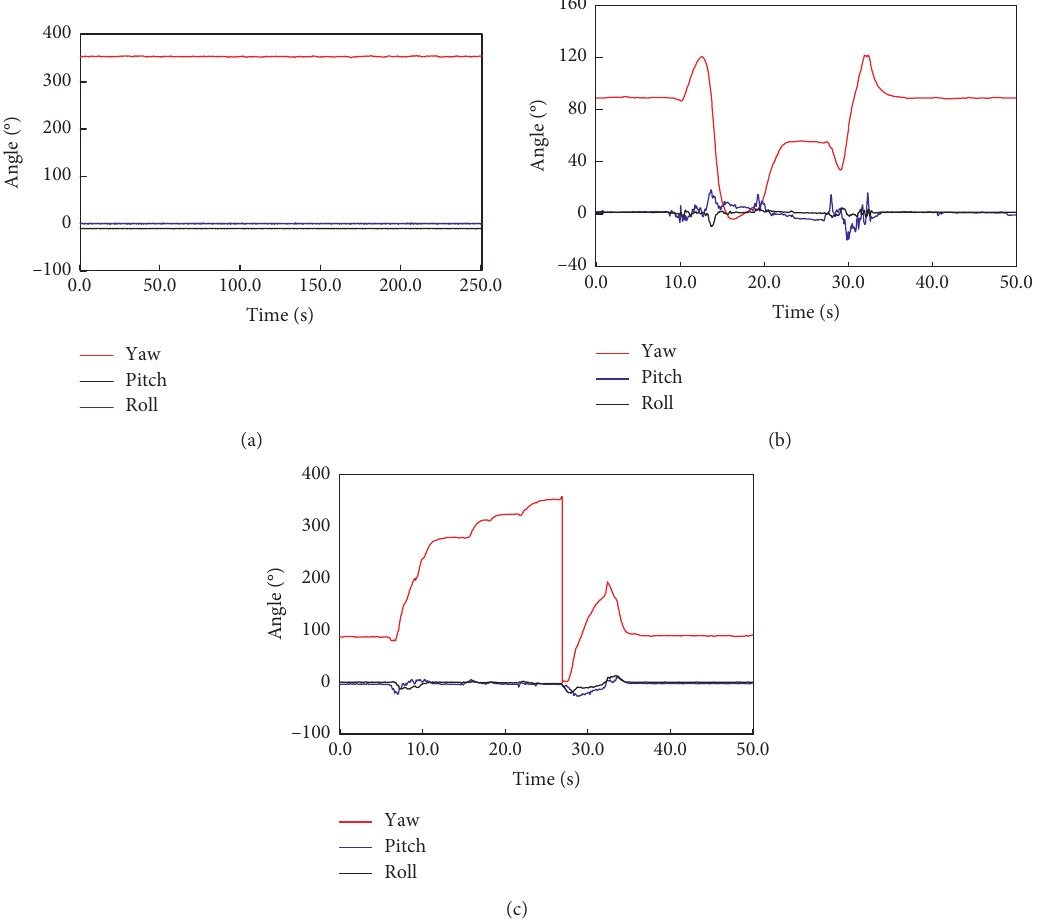
Figure 4: (a) The sensor is resting is the calculated angle value. (b) Angle change before magnetic field correction. (c) Angle change after magnetic field